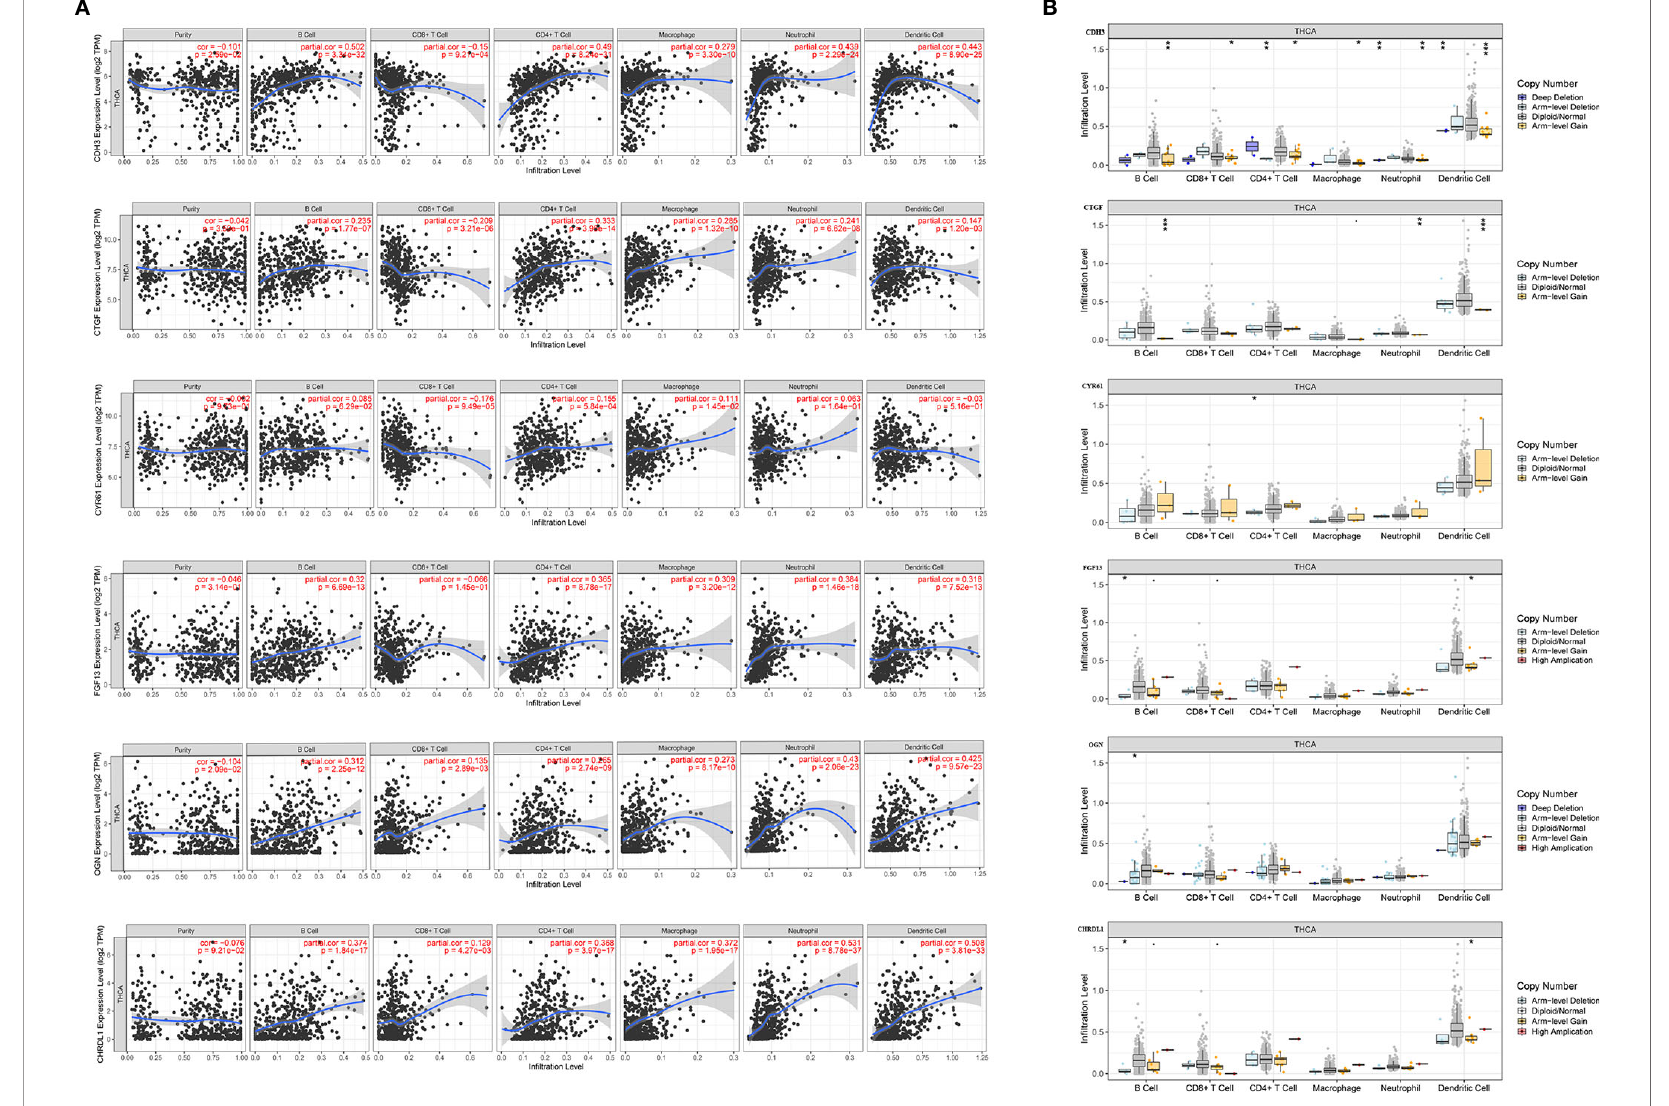
FIGURE 13 | Correlation of expression of the six hub genes with immune in fi ltration in THCA. (A) Correlation of genes including CDH3, CTGF, CYR61, FGF13, OGN , and CHRDL1 with tumor purity, and in fi ltration of B cells, CD8+ T cells, CD4+ T cells, macrophages, neutrophils, and dendritic cells. (B) The effect of copy number variation of CDH3, CTGF, CYR61, FGF13, OGN , and CHRDL1 on the distribution of various immune cells. (*p < 0.05; **p < 0.01; ***p <